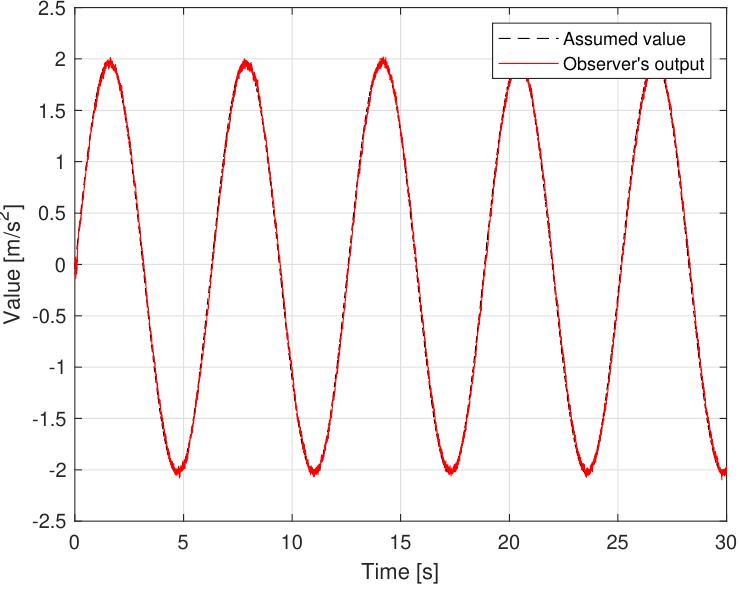
Figure 8. Time evolution of observer output versus assumed disturbance.